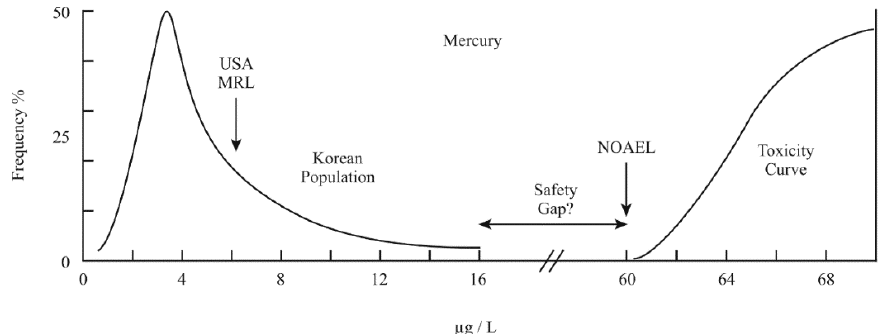
Figure 1. Distribution of blood mercury levels in a Korean population [31,32] compared to the USA MRL level (minimum risk level) and the NOAEL (no observable adverse effect level) toxicity curve onset, µg/L.